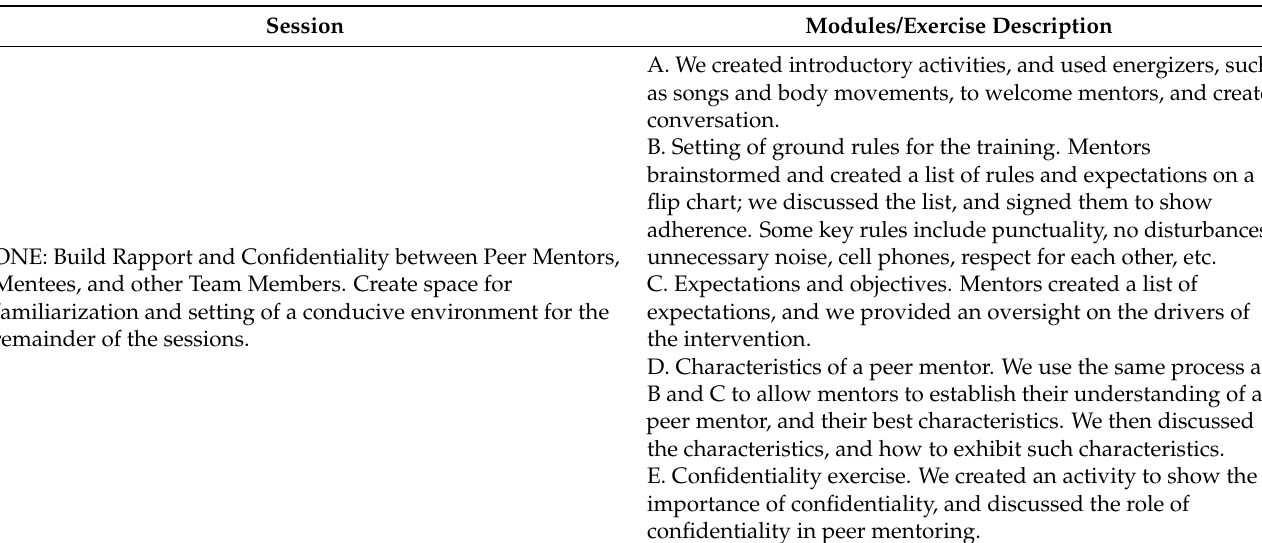
Table 1. Description of module sessions and module exercises. Session Modules/Exercise